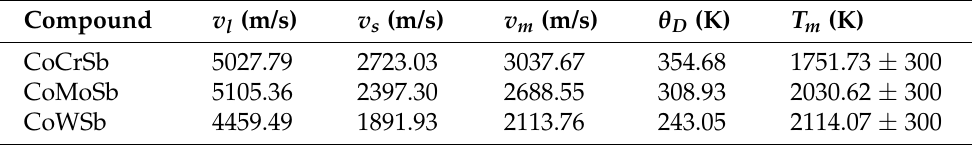
Table 6. Average sound velocity ( v m ), compressional velocity ( v l ), shear sound velocity ( v s ),